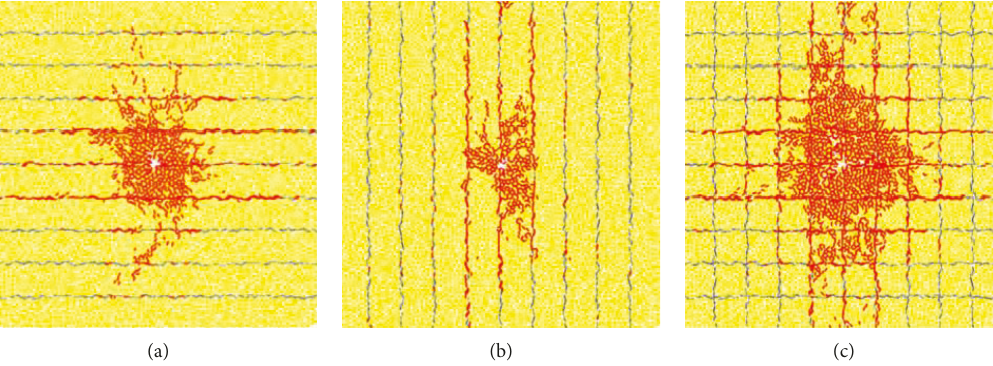
Figure 17: The distribution of hydraulic fractures of jointed samples: (a) layered jointed sample, (b) vertical jointed sample, and (c) orthogonal jointed sample